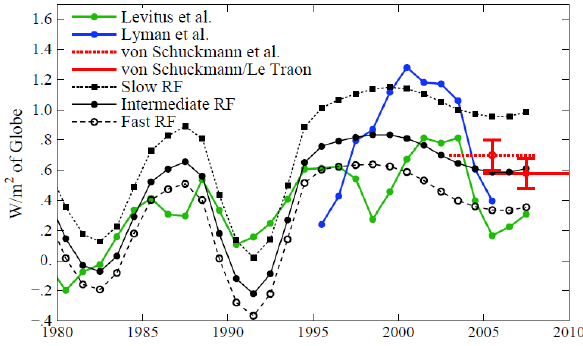
Fig.10. (a) Estimated contributions to planetary energy imbalance in 1993-2008, and (b) in 2005-2010. Except for heat gain in the abyssal ocean and Southern Ocean, ocean heat change beneath the upper ocean (top 700 m for period 1993-2008, top 2000 m in period 2005-2010) is assumed to be small and is not included. Data sources are the same as for Figs. 8 and 9. Vertical whisker in (a) is not an error bar, but rather shows the range between the Lyman et al. (2010) and Levitus et al. (2009) estimates. Error bar in (b) combines estimated errors of von Schuckmann and Le Traon (2011) and Purkey and Johnson (2010).